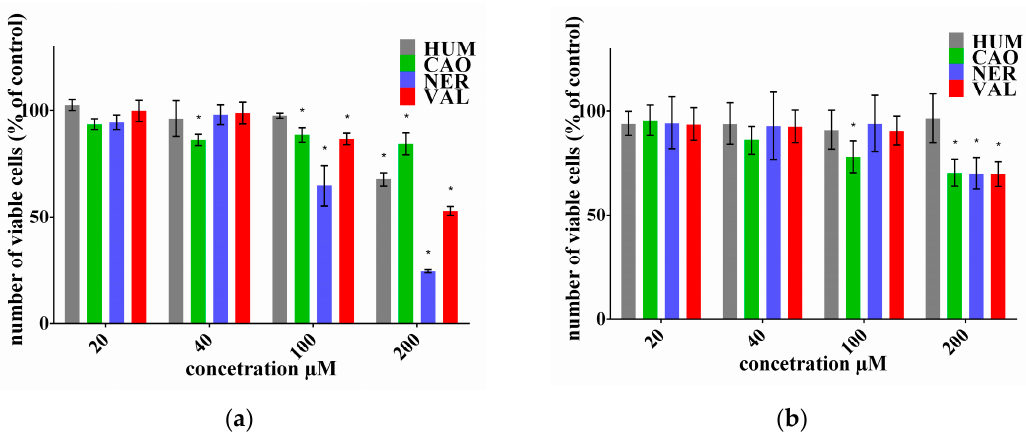
Figure 2. Effect of sesquiterpenes on proliferation of lymphoblast cell lines CCRF/CEM ( a ) and CEM/ADR ( b ). The number of viable cells was assayed using AB. Data presented as a percentage share of controls (=100%) represent the mean ± S.D. calculated from 3 independent measurements (6 parallels in each). The asterisk indicates a significant difference from the control cells ( p < 0.05).